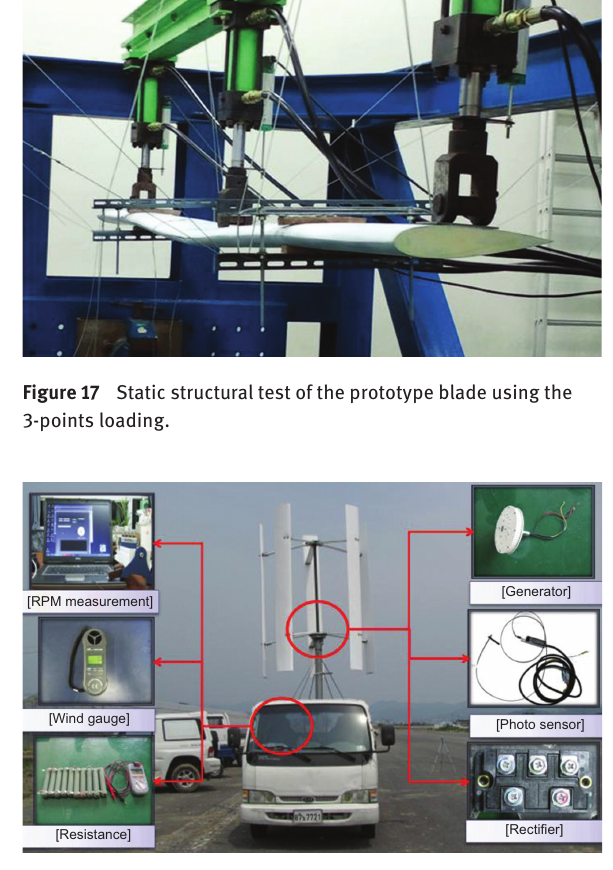
Figure 18 Test setup for performance test of prototype small VAWT.